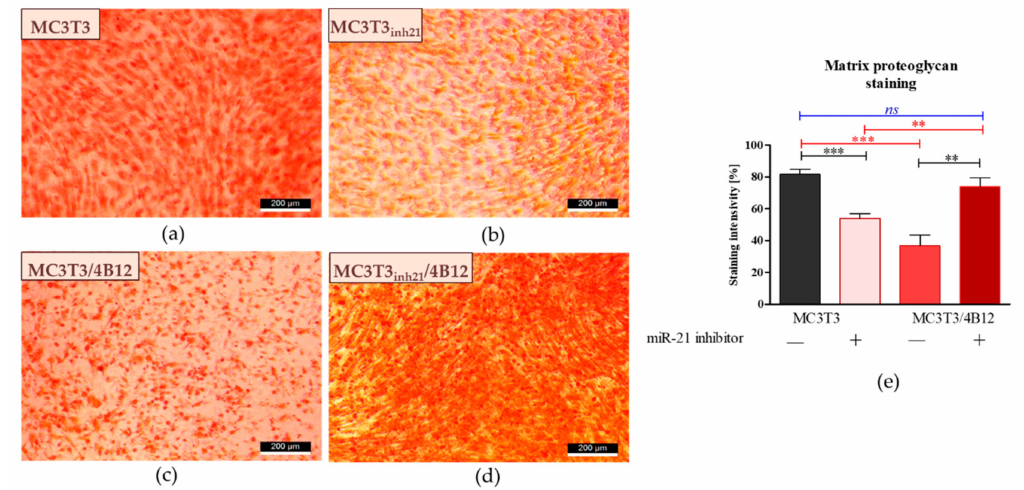
Figure 4. Representative images showing detection of proteoglycans with Safranin-O. The images show the e ff ect of miR-21 inhibition on proteoglycan accumulation within the extracellular matrix formed by pre-osteoblasts under osteogenic conditions. Additionally, influence of osteoclast precursors on MC3T3 di ff erentiation was evaluated. Osteogenic di ff erentiation of MC3T3 was associated with increased accumulation of proteoglycans ( a ). The decreased content of proteoglycans was observed in cultures of MC3T3 transfected with miR-21 inhibitor ( b ). The influence of 4B12 pre-osteoclast presence during osteogenic di ff erentiation of MC3T3 was monitored. The analysis revealed that osteoclasts presence decreased the accumulation of proteoglycans ( c ). In turn, extracellular matrix which formed in co-cultures of MC3T3 inh21 with osteoclasts was rich in proteoglycans ( d ). Images were taken under 100-fold magnification (scale bar indicated). The staining intensity was determined using ImageJ software with Pixel Counter application, as indicated in Materials and Methods section ( e ). Significant di ff erences are indicated with asterisks (** p < 0.01 and *** p < 0.001), while non-significant di ff erences are marked as ns . The comparisons between groups are marked with square